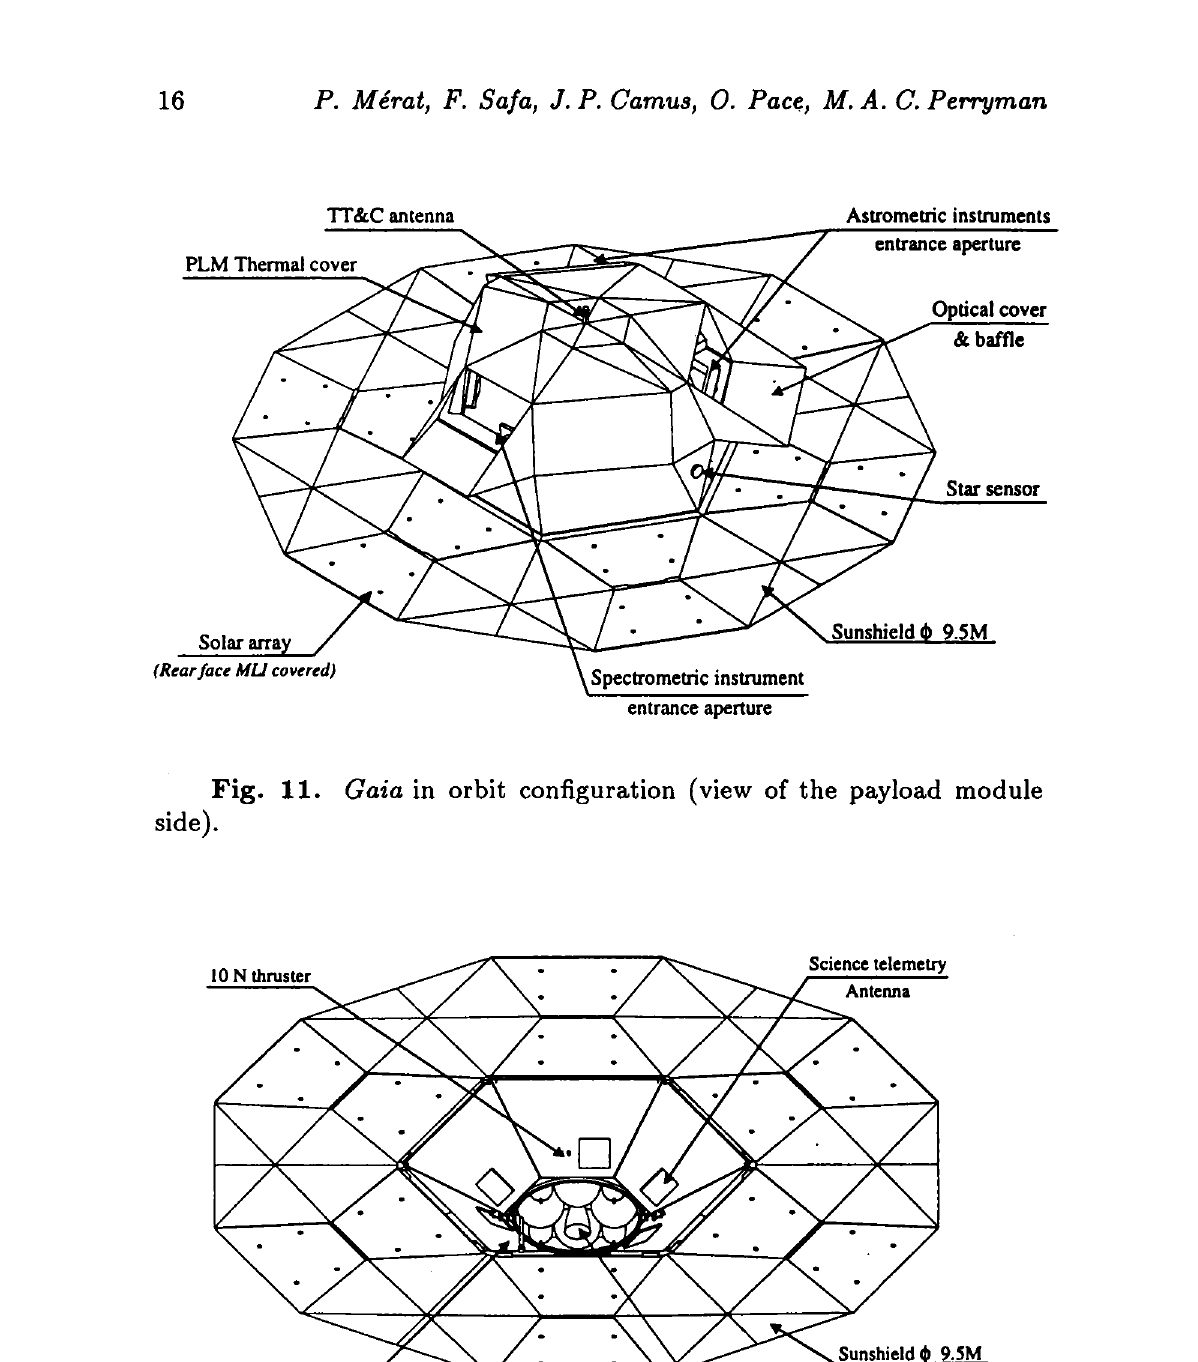
Fig. 12. Gaia in orbit configuration (view of the service module